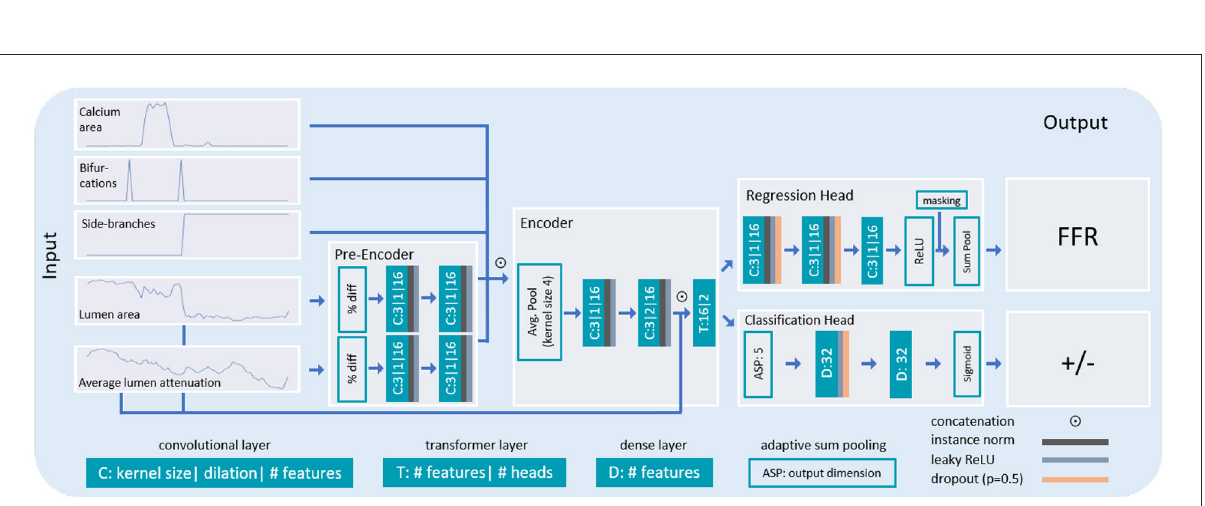
FIGURE5 Architecture of the network used for stenosis assessment. The lumen area and its attenuation predicted by the characterization network are first pre-encoded and subsequently concatenated with the calcium area, and with additional characteristics indicating bifurcations and whether the analysis is performed in the main- or side-branch of the artery. The combined encodings are thereafter fed to the encoder. In the encoder, the features are first pooled and thereafter, convolutions and a transformer layer are applied. For final classification, two separate output heads are applied. In the regression head, two convolutional layers and the ReLU activation function are used. The resulting sequence is pooled along the artery dimension and subtracted from 1 to yield a single FFR value. In the classification head, the features are pooled to a fixed length of 5 (2.5 mm). Thereafter, two dense layers are used in combination with the sigmoid activation function to yield output probabilities for the presence of a functionally significant stenosis in the